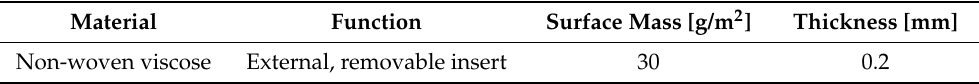
Table 2. Characteristic of the non-woven viscose